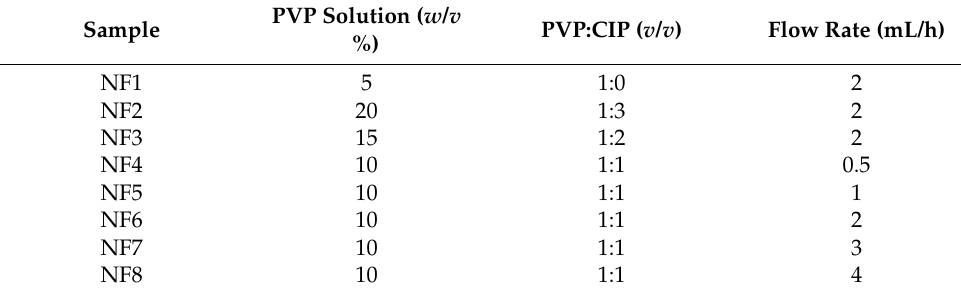
Table 2. The composition of each sample and their preparation procedures.